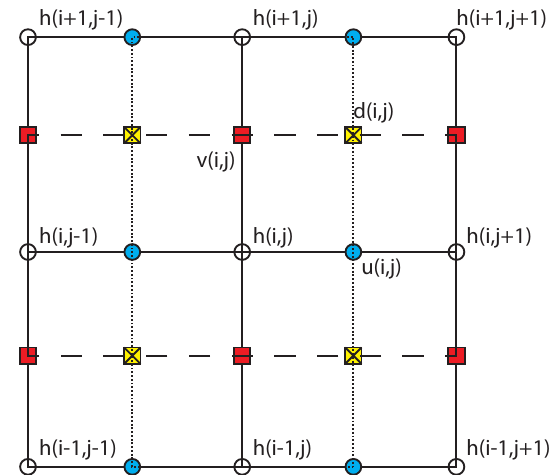
Figure 2. Staggered grids used in the model: the basic grid is the ice-thickness grid (shown in open circles). u and v velocities for the ice shelves (and ice streams) are calculated on two different staggered Arakawa C grids (filled circles and squares, respectively). Diffusion coefficients d in the ice sheet equation are solved on an Arakawa B grid (crossed